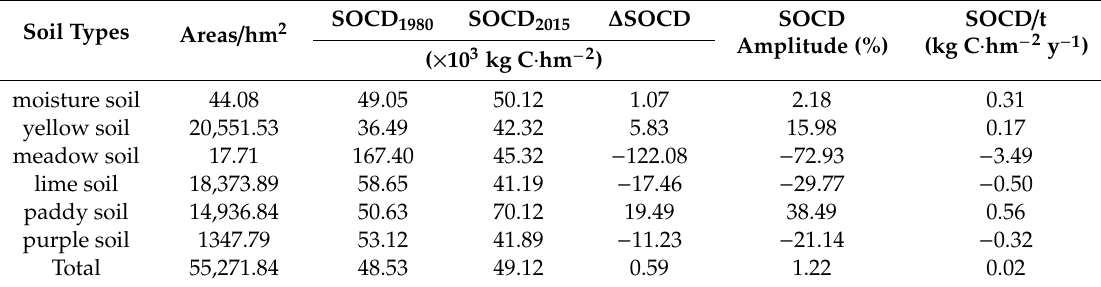
Table 4. Changes of organic carbon density in surface soil of farmland in Puding County from 1980 to 2015.